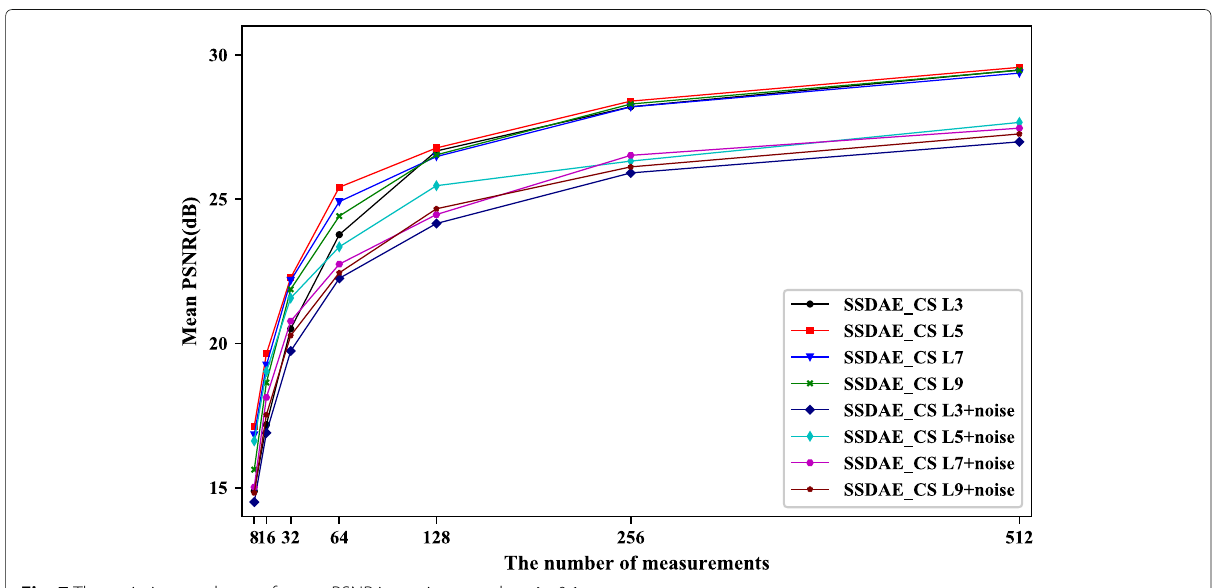
Fig. 7 The variation tendency of mean PSNR in testing set when λ =0.1